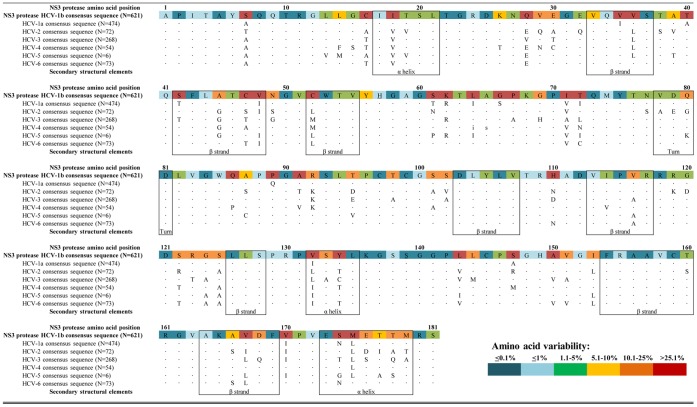
Amino acid sequence alignment of HCV genotypes 1–6 NS3 protease.The secondary structural elements identified from the HCV-1 NS3 crystal structures are reported at the bottom of the sequences. The consensus sequence of HCV-1b NS3-protease is shown as a reference, colored according to the frequency rate of mutations observed in 1568 HCV-sequences. HCV sequences reported are the consensus sequences obtained from the datasets included in the analysis. Secondary structural elements are indicated as reported in ViralZone (http://viralzone.expasy.org/). Catalytic residues (H57-D81-S139) are underlined. Identical amino acids among all HCV genotypes are indicated with dots “•”.